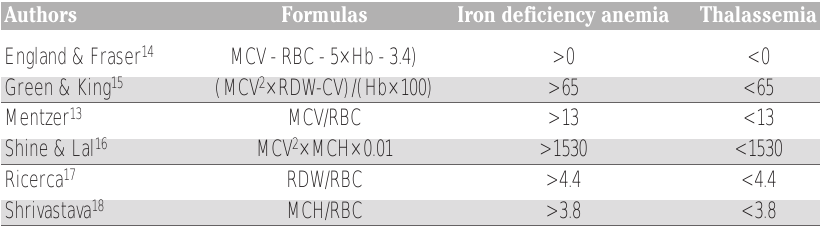
Table 1. Overview of discrimination formulas including cut-off levels for iron deficiency anemia and for b